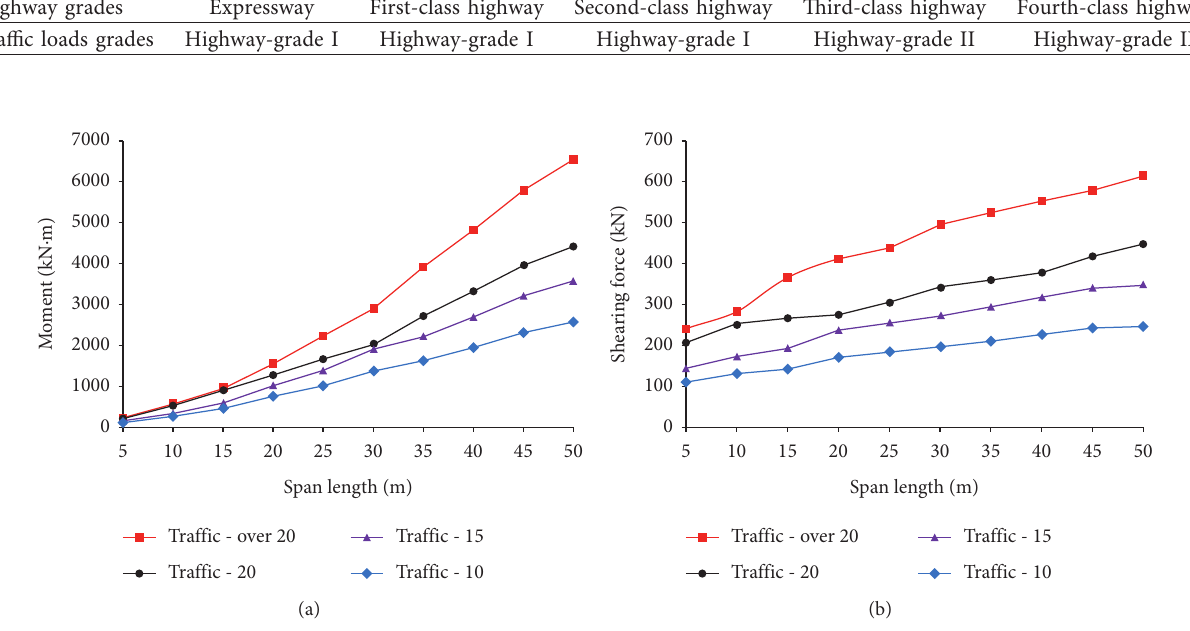
Figure 3: Traffic loading effects in JTJ 021-89: (a) moment and (b) shearing